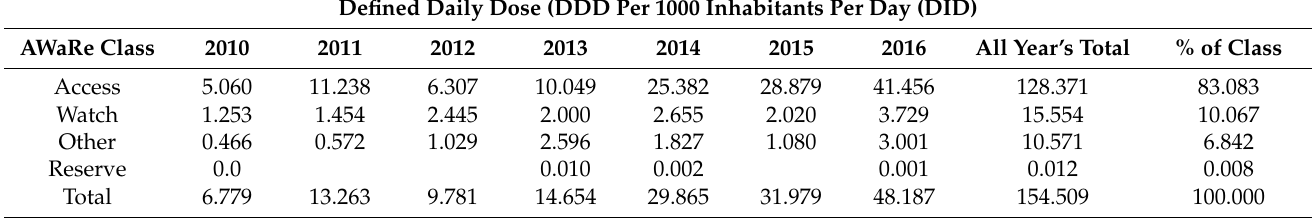
Table 2. Distribution of Defined Daily Dose (DDD per 1000 inhabitants per day (DID)) of antibiotics per the World Health organizations’ AWaRe class for antibiotics utilized in Tanzania from 2010 to 2016.